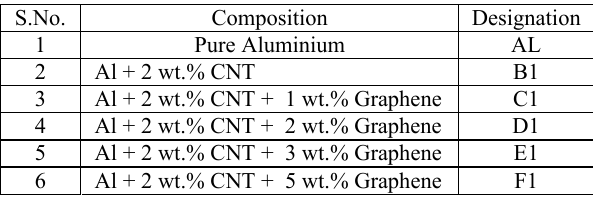
Figure 1. SEM micrographs of procured (a) CNTs and (b) graphene. Table 1. Designation of hybrid composite samples S.No.